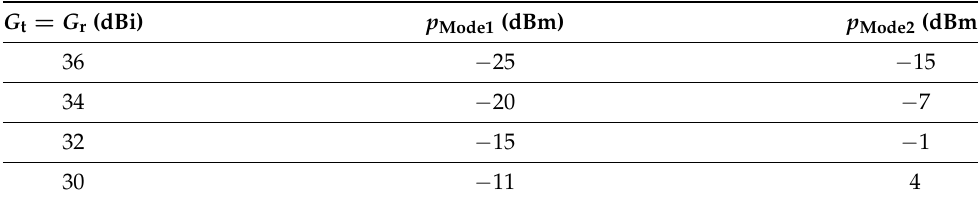
Table 3. Minimum required transmit power of two